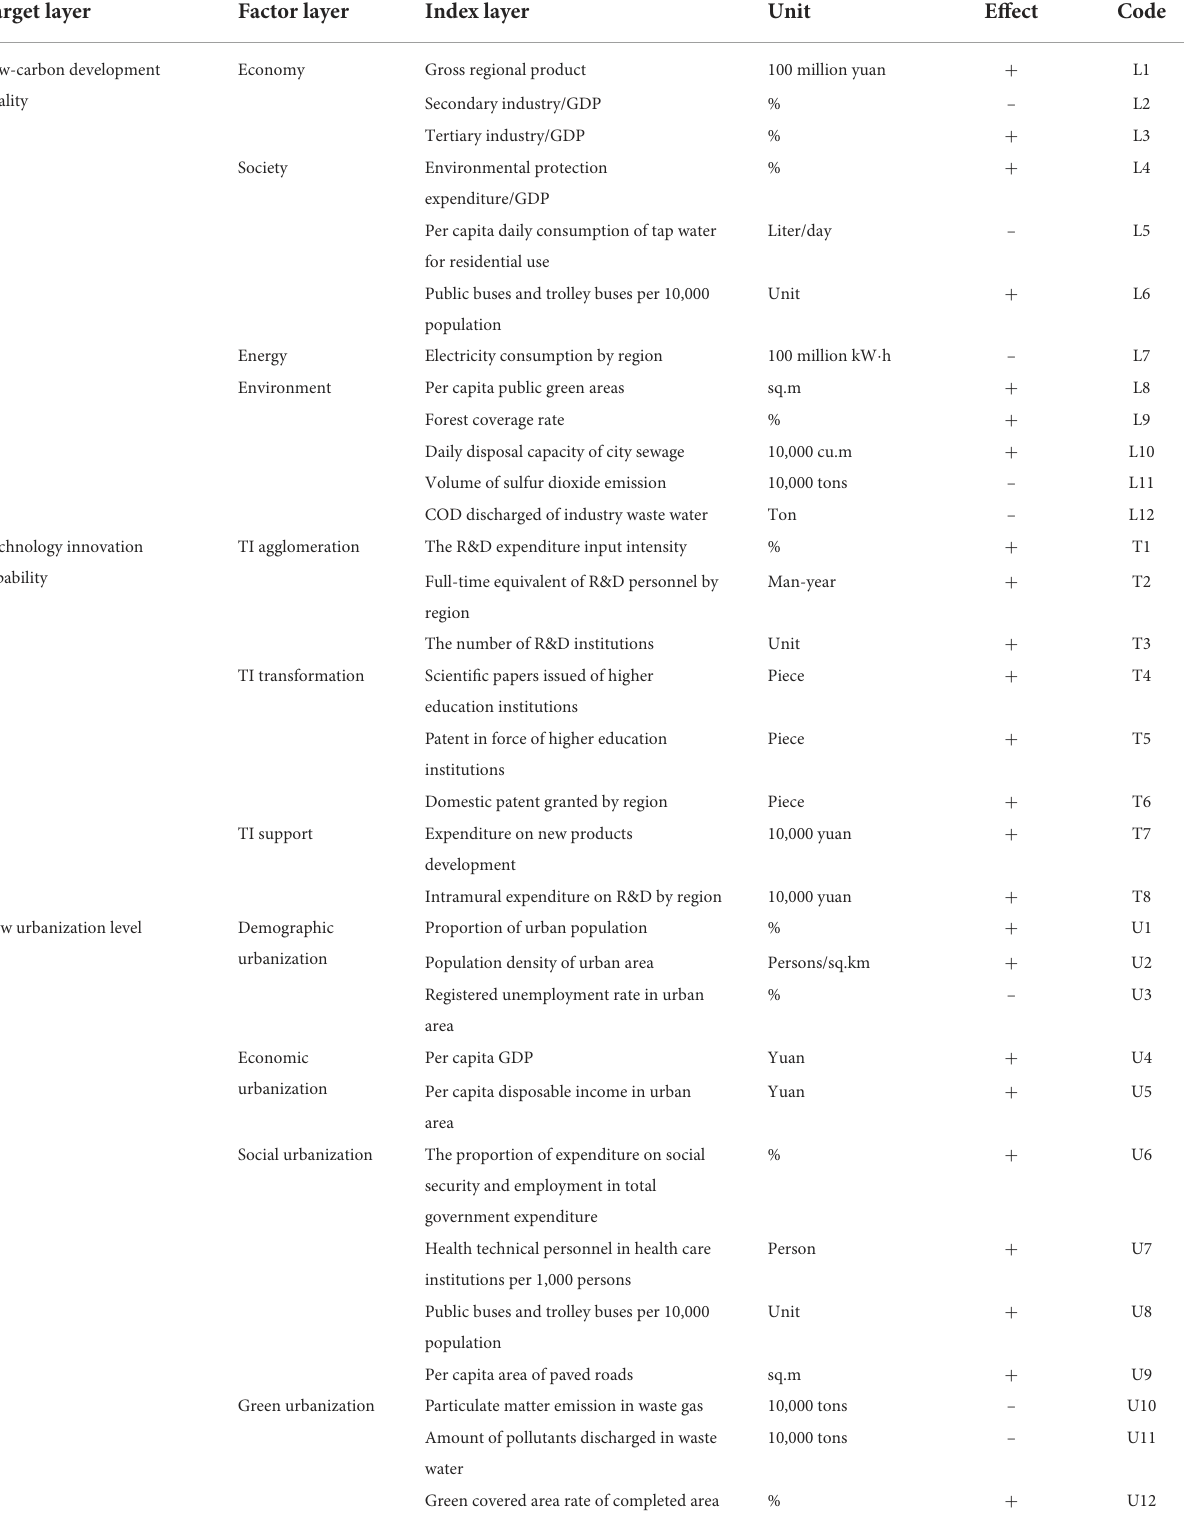
TABLE 2 The index system of LCD quality/TI capability/NU